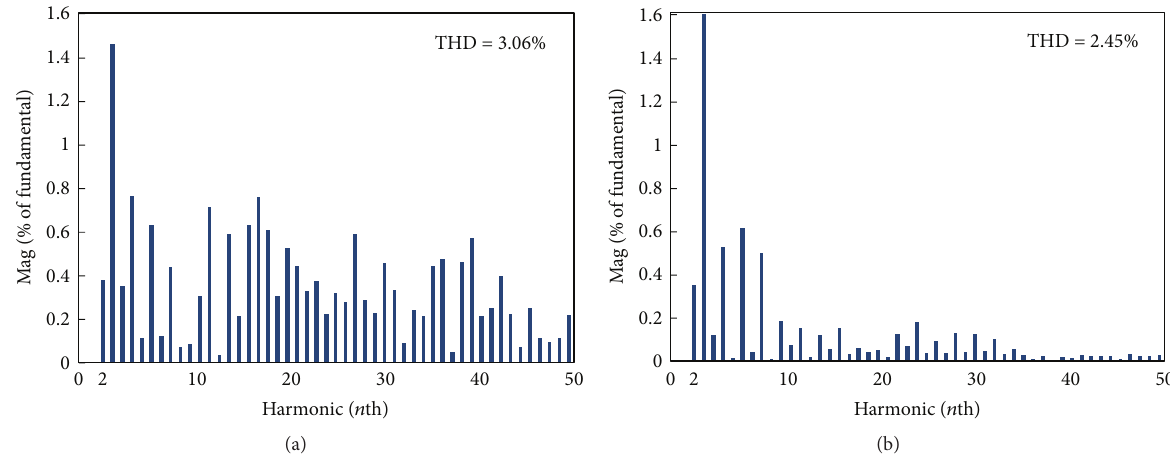
Figure 10: THD of grid-connected current: (a) THD of the grid-connected current with conventional FS-MPC. (b) THD of the grid- connected current with simplified FS-MPC.